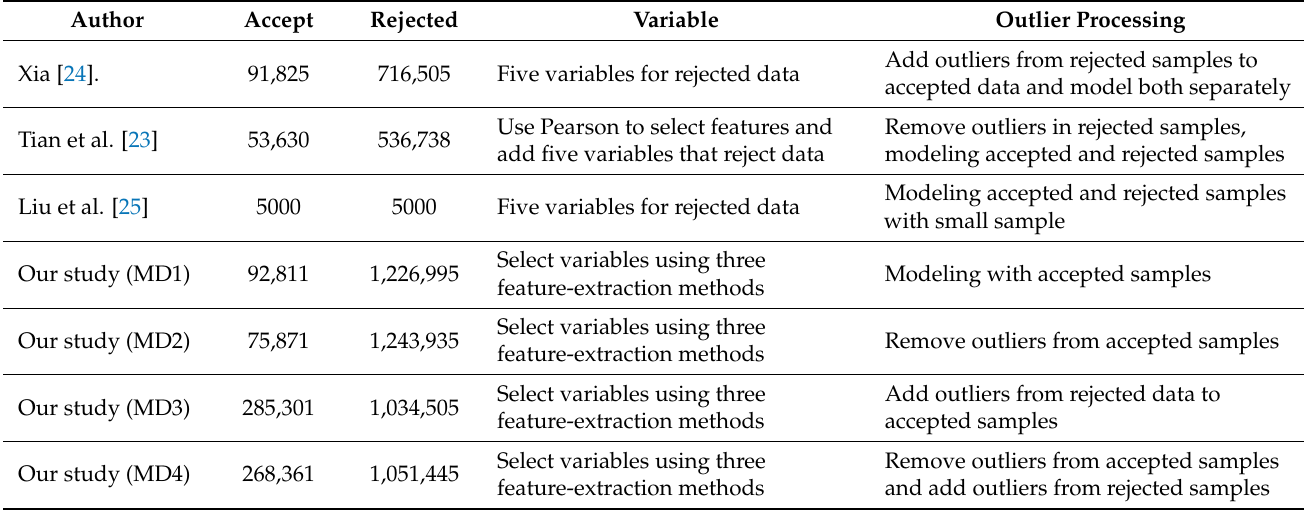
Table 8. The comparison of the sample size and outlier processing with previous